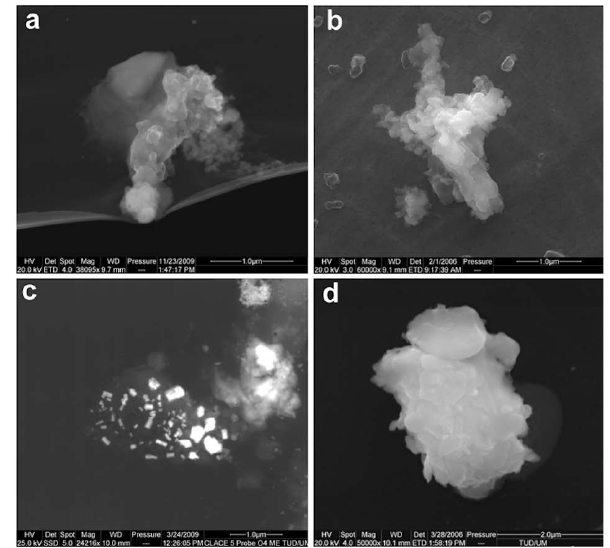
Fig. 2. Secondary electron image of (a) C-O-S particle, (b) Al-rich particle; (c) Pb-bearing particle (bright inclusions) and (d) complex internal mixture